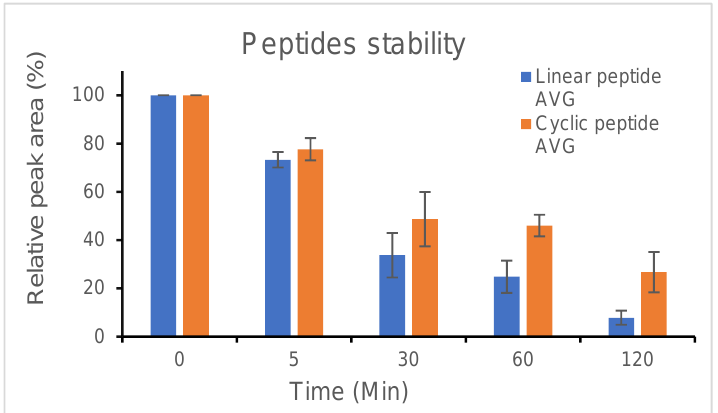
Figure 7. Stability studies of the linear peptide, CVP-198, and the bioactive backbone cyclic peptide, CVP-199. The stability of the peptides was measured independently under tryptic degradation at 37 °C (by trypsin degradation of the peptide) and was determined by HPLC analysis (for more experimental details, see “Materials and Methods”) ( n = 3). The starting time point (0 min, 100%) represents the peptide at the beginning of each experiment. Linear peptide (CVP-198) at 37 °C with trypsin (blue), and cyclic peptide (CVP-199) at 37 °C with trypsin (orange), were analyzed after 0 min, 5 min, 30 min, 60 min, and 120 min. Separation was performed by HPLC in the presence of 0.1% trifluoroacetic acid and detected by absorbance at 214 nm. Peptide amounts were calculated relative to the quantities determined at time point